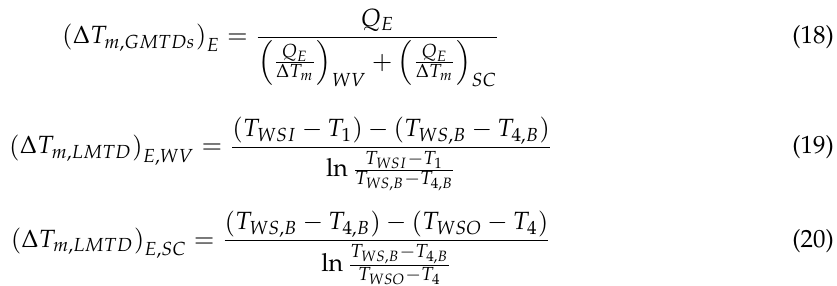
Figure 8. Evaluation of the heat exchange process in the evaporator using GMTD S method. The GMTD S in the evaporator, ( ∆ T m,GMTDs ) E , is defined using the following equations: